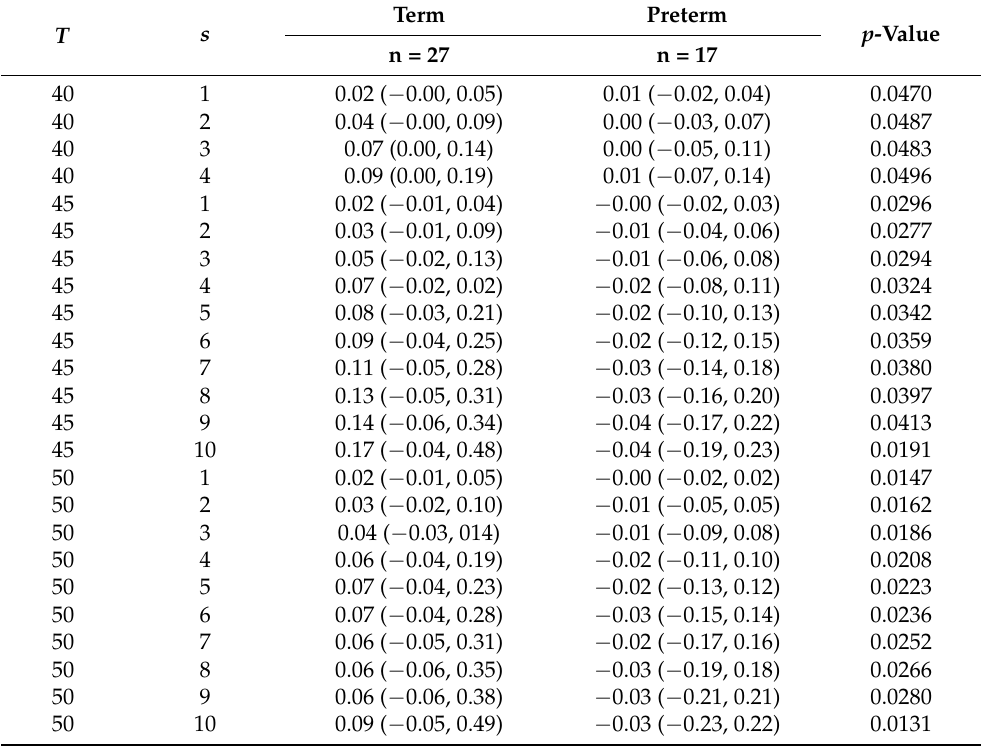
Table 2. Significant DR values (median and interquartile range in (ms) for the Term and Preterm